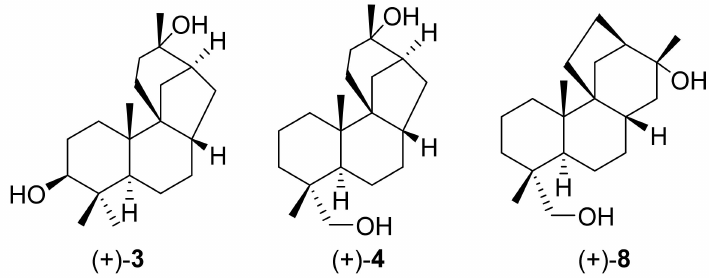
Figure 7. (+)-Maritimol ( 3 ), (+)-stemodinol ( 4 ) and (+)-stemarin ( 8 ).